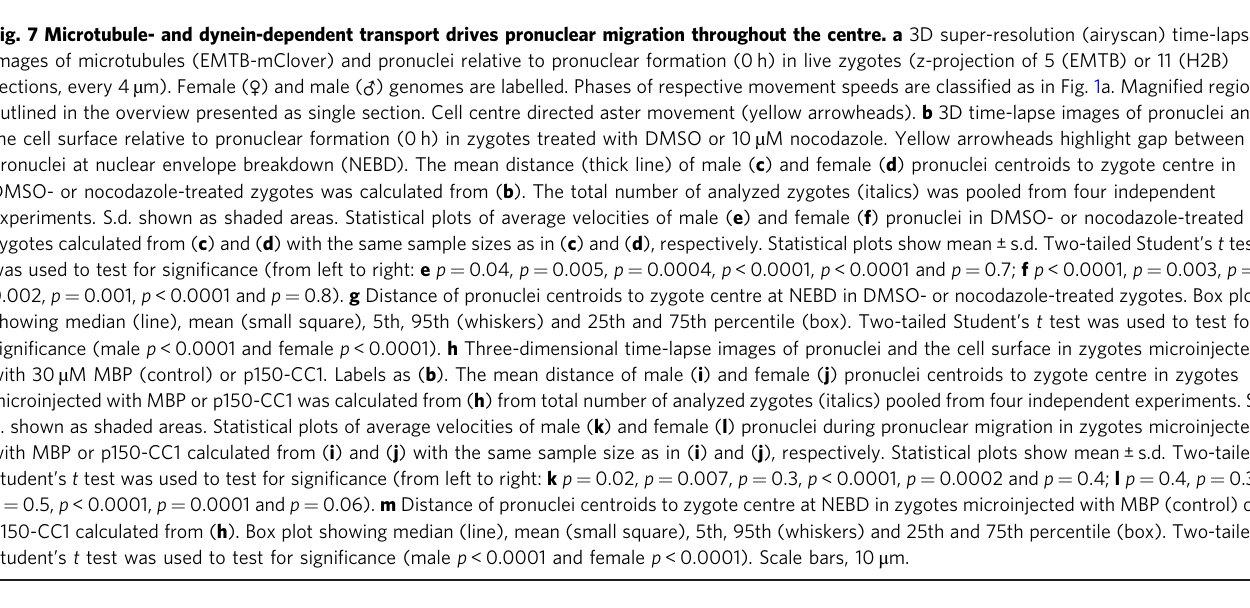
p150-CC1 calculated from ( h ). Box plot showing median (line), mean (small square), 5th, 95th (whiskers) and 25th and 75th percentile (box).